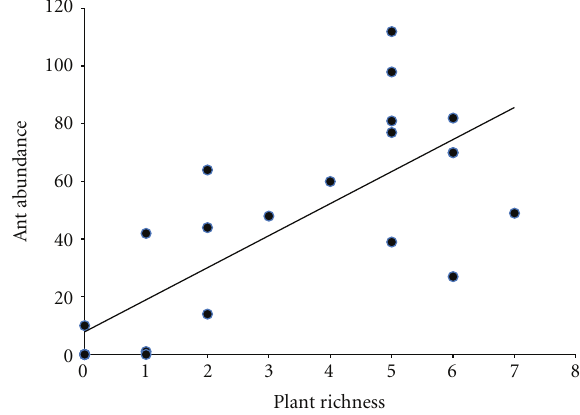
Figure 8: Relationship between plant richness and ant abundance from samples collected at Mount St. Helens National Volcanic Monument between 22 and 25 July 2008. This relationship repre- sents a significant positive correlation (Spearman rank correlation coe ffi cient = 0.784, P < 0 . 001). The equation for the fitted line is y = 11 . 12 x + 7 .